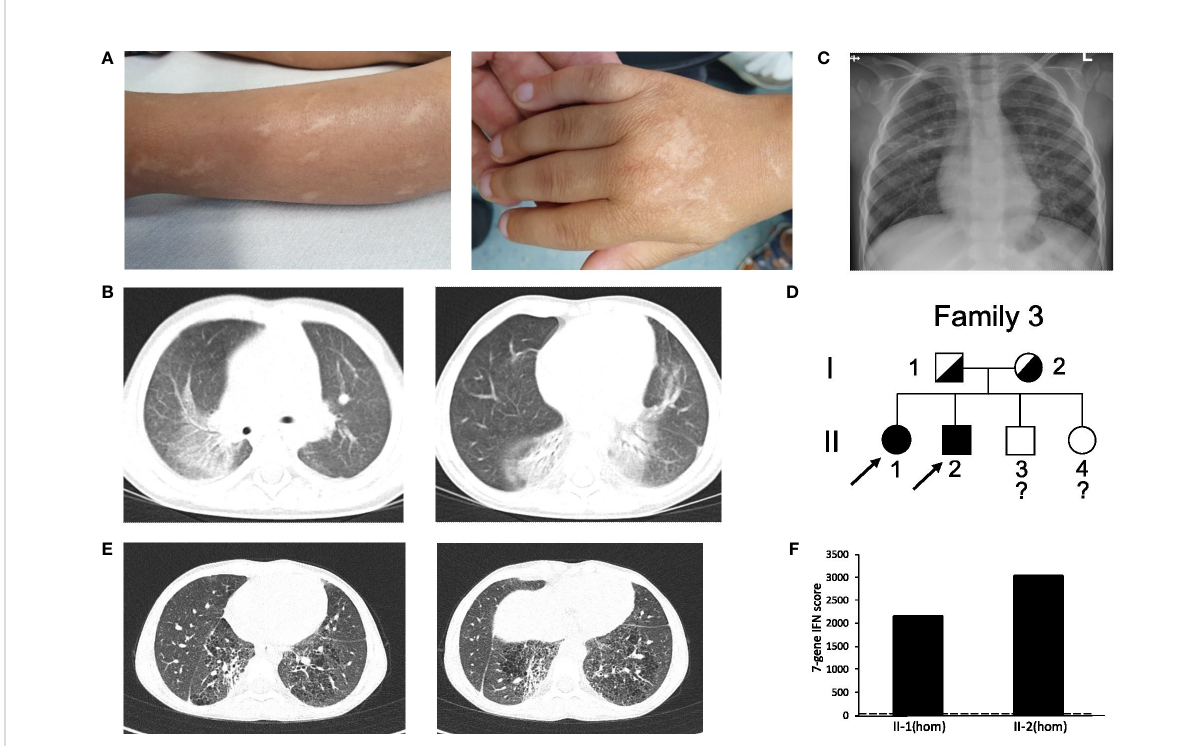
FIGURE 3 Clinical features and pedigree of patient 3 and 4. (A) scars of the SAVI skin disease during infancy without activity in patient 3. (B) CT of patient 3 at the age of three years displaying ground glass opacities, atelectasis, interlobar septal thickening and cystic changes. (C) Chest X-ray of the patient 3, displaying bilateral interstitial lung disease and depended dystelectasis. (D) Pedigree of patient 3 and 4 ’ s family; fi lled symbol: homozygosity; half- fi lled symbol, heterozygosity; clear symbol: unaffected;?, no information about genotype; arrow indicates index patient 3 (II- 2) and 4 (II-1). (E) CT of patient 4 showing fi brotic and cystic lesions. (F) IFN score from whole blood for patient II-2 and II-1; homozygosity (hom); dash line indicates threshold of 12.49 from healthy